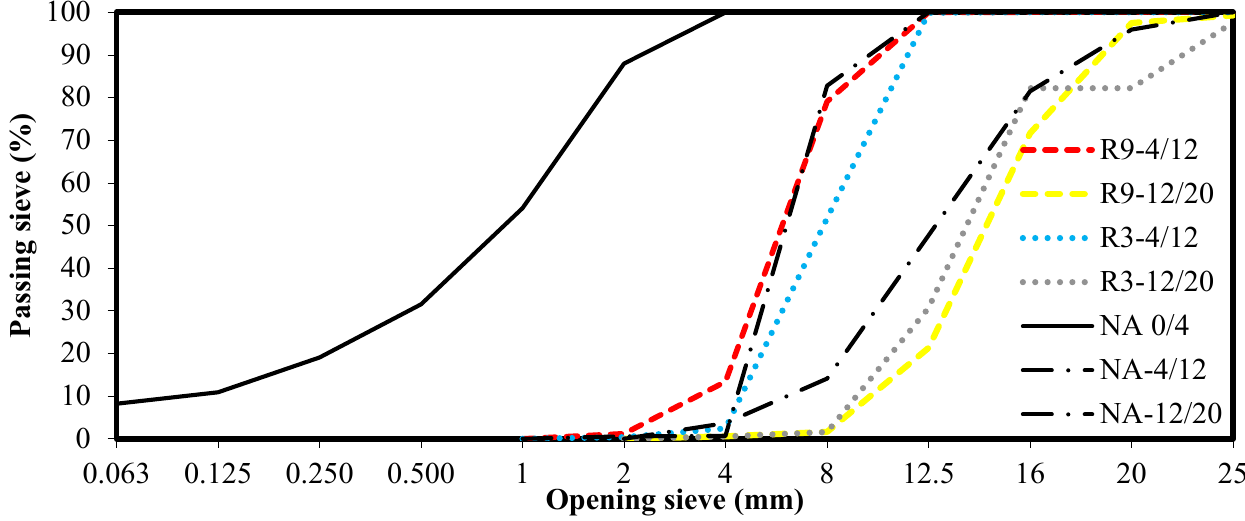
Figure 2. Particle size distribution of aggregate.